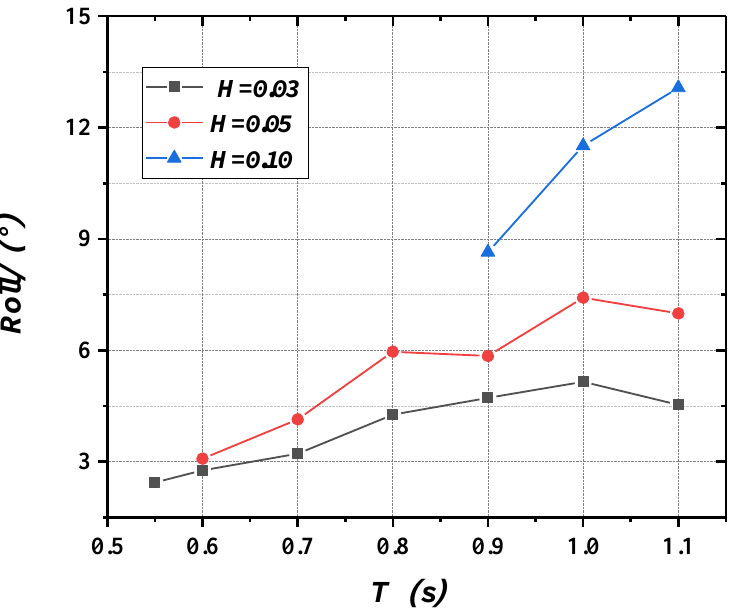
Figure 27. Variations of roll with period and wave height.